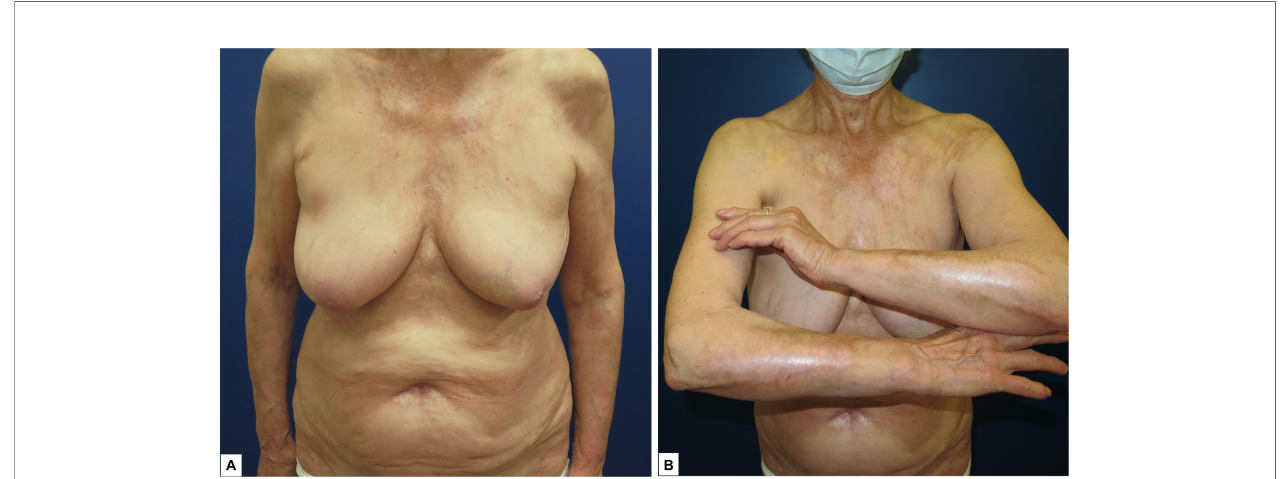
FIGURE 4 | (A,B) Signi fi cant improvement of the lesionsafter the introduction ofsystemic steroids with complete resolution of the erosionsafter 4